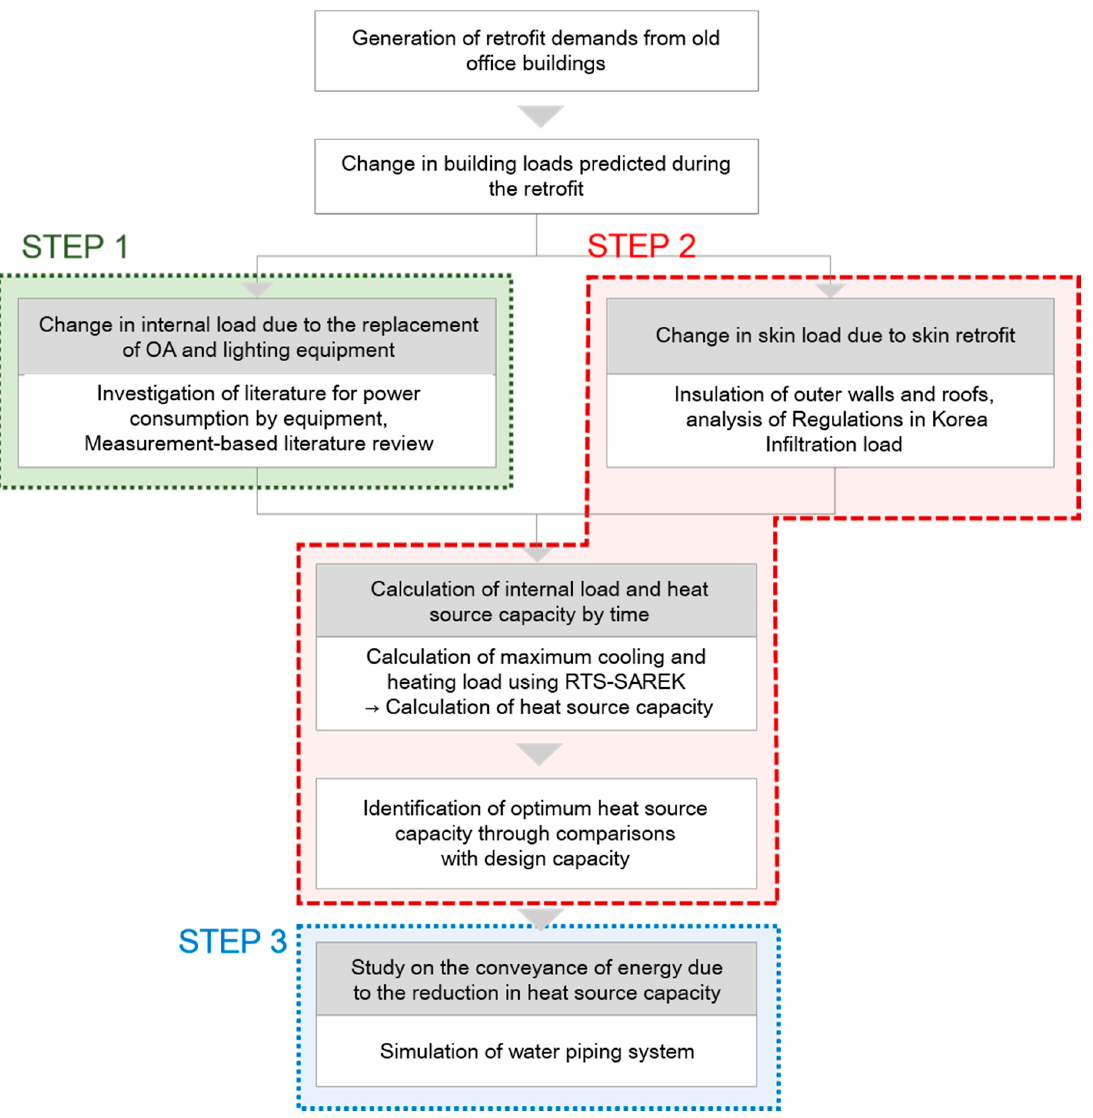
Figure 1. Overall research flow chart for the optimal heat source system retrofit. Table 1. Detailed items of literature reviews by load factor.